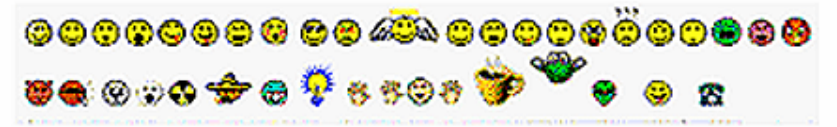
Figure 2. Examples of emoticons available in the